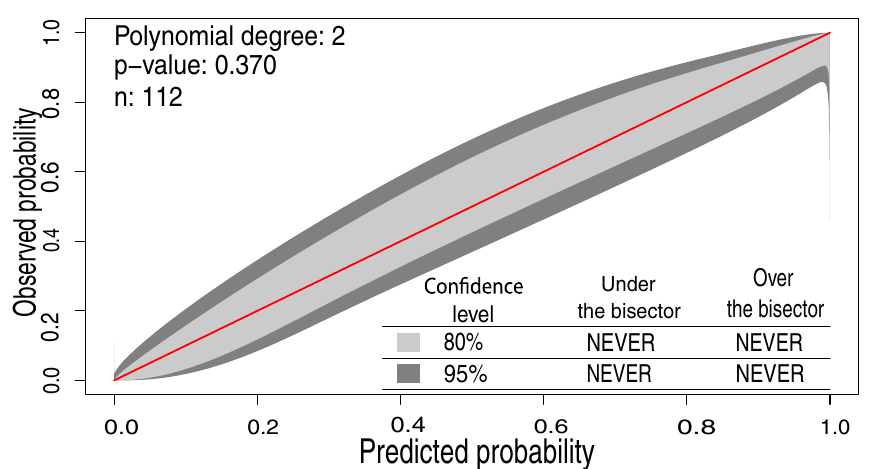
Figure 4. The GiViTI calibration belt for the nomogram of predicting the breast pathologic complete response rate of breast cancer patients after neoadjuvant chemotherapy.